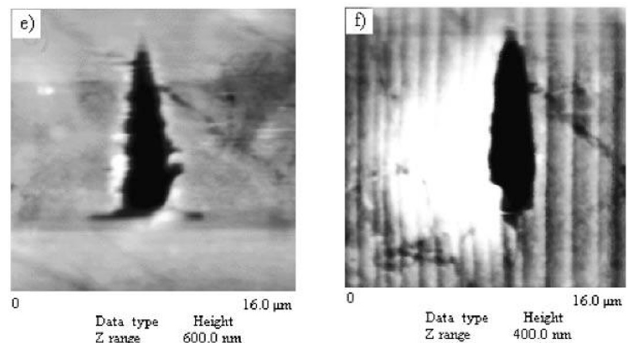
Figure 16. Atomic force microscope images of residual scratches on the (110) face of thiohydantoin crystal. ( a ) Along the skewed layers direction showing pile-up only on both sides, ( b ) scratch along the cleavage plane resulting in pile-up only on the right side, ( c ) horizontal cross-section profile at the broadest width in ( a ), ( d ) horizontal cross-section profile at the broadest width in ( b ), ( e ) scratch against the sloping of the skew layers showing no-pile up, and ( f ) scratch along the cleavage planes resulting in pile-up only on the left side. (Reproduced with permission from the Wiley, Reference 107).